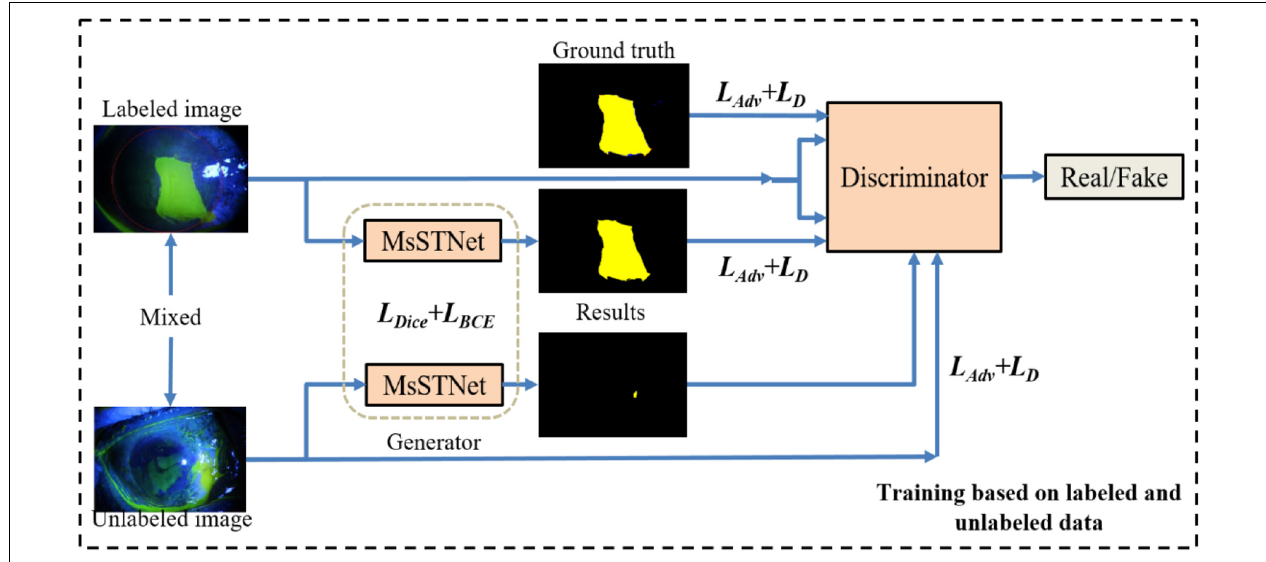
FIGURE 2 | Framework of the proposed semi-supervised multi-scale self-transformer generative adversarial network (Semi-MsST-GAN). In the semi-supervised training process based on labeled and unlabeled images, for the data with ground truth, the multi-scale self-transformer network (MsSTNet) is trained to segment the corneal ulcer region as close to the corresponding ground truth as possible based on the guidance of the objective function of L joint . Then, the segmentation result of MsSTNet is concatenated with the original data and fed into the discriminator. At the same time, the ground truth is concatenated with the original data. They are all fed into the discriminator to discriminate whether the input pair is real or fake based on the objective function of L D . For the data without ground truth, MsSTNet is trained to segment the corneal ulcer region to confuse the discriminator to predict fake results based on the objective function of L adv . Then, the segmentation result of MsSTNet is concatenated with the original data and fed into the discriminator. The discriminator is trained to discriminate whether the input pair is real or fake based on the objective function of L D